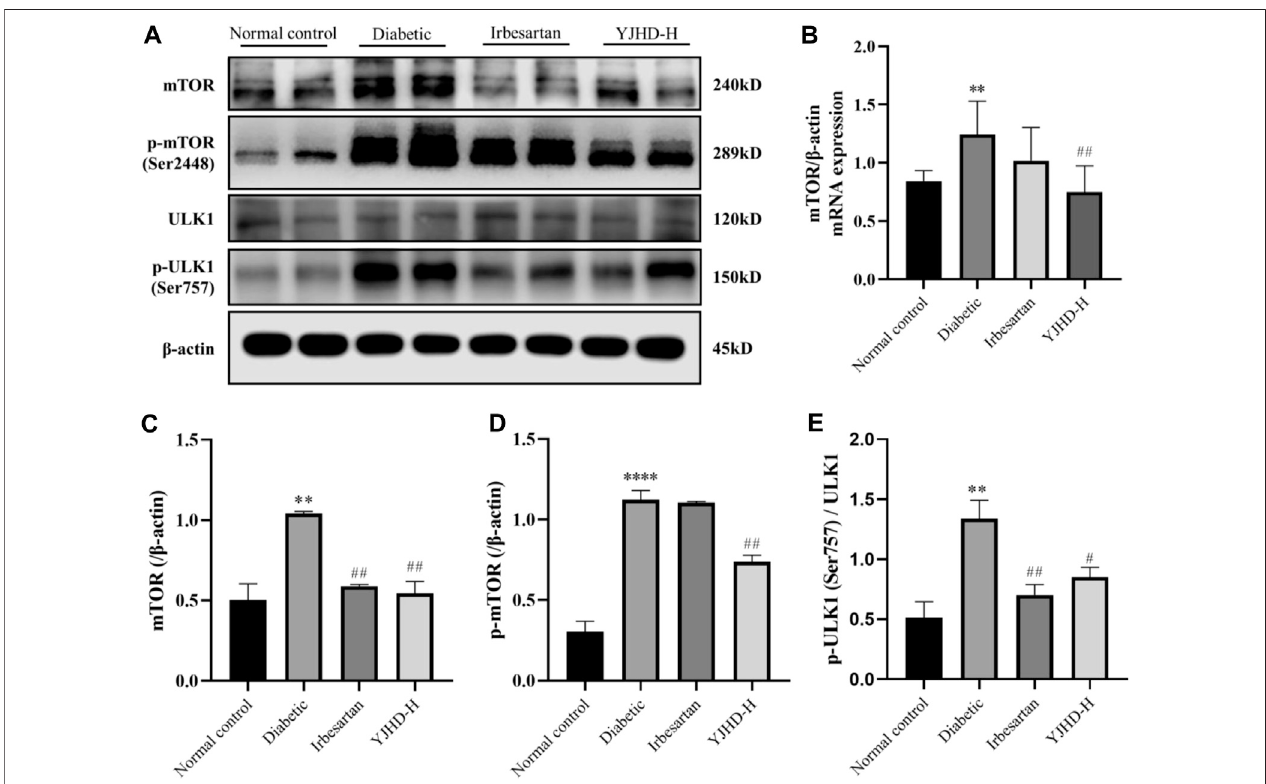
FIGURE 7 | Effectsof Yiqi Jiedu Huayu decoction (YJHD) on mTOR pathway. (A) Protein levels ofmTOR, p-mTOR, ULK1, and p-ULK1 were detected by western blotting. (B) mRNA expression of mTOR was detected by PCR. (C – E) Protein concentration analysis. Data are expressed as * p < 0.05, ** p < 0.01, and *** p < 0.001: compared with the normal control group; ## p < 0.01: compared with the diabetic